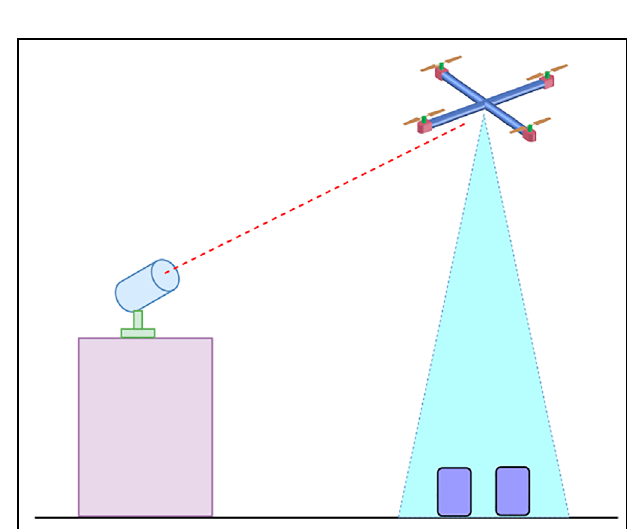
FIGURE 8 | Wireless recharging of UAVs by laser beam technology (Galkin et al.